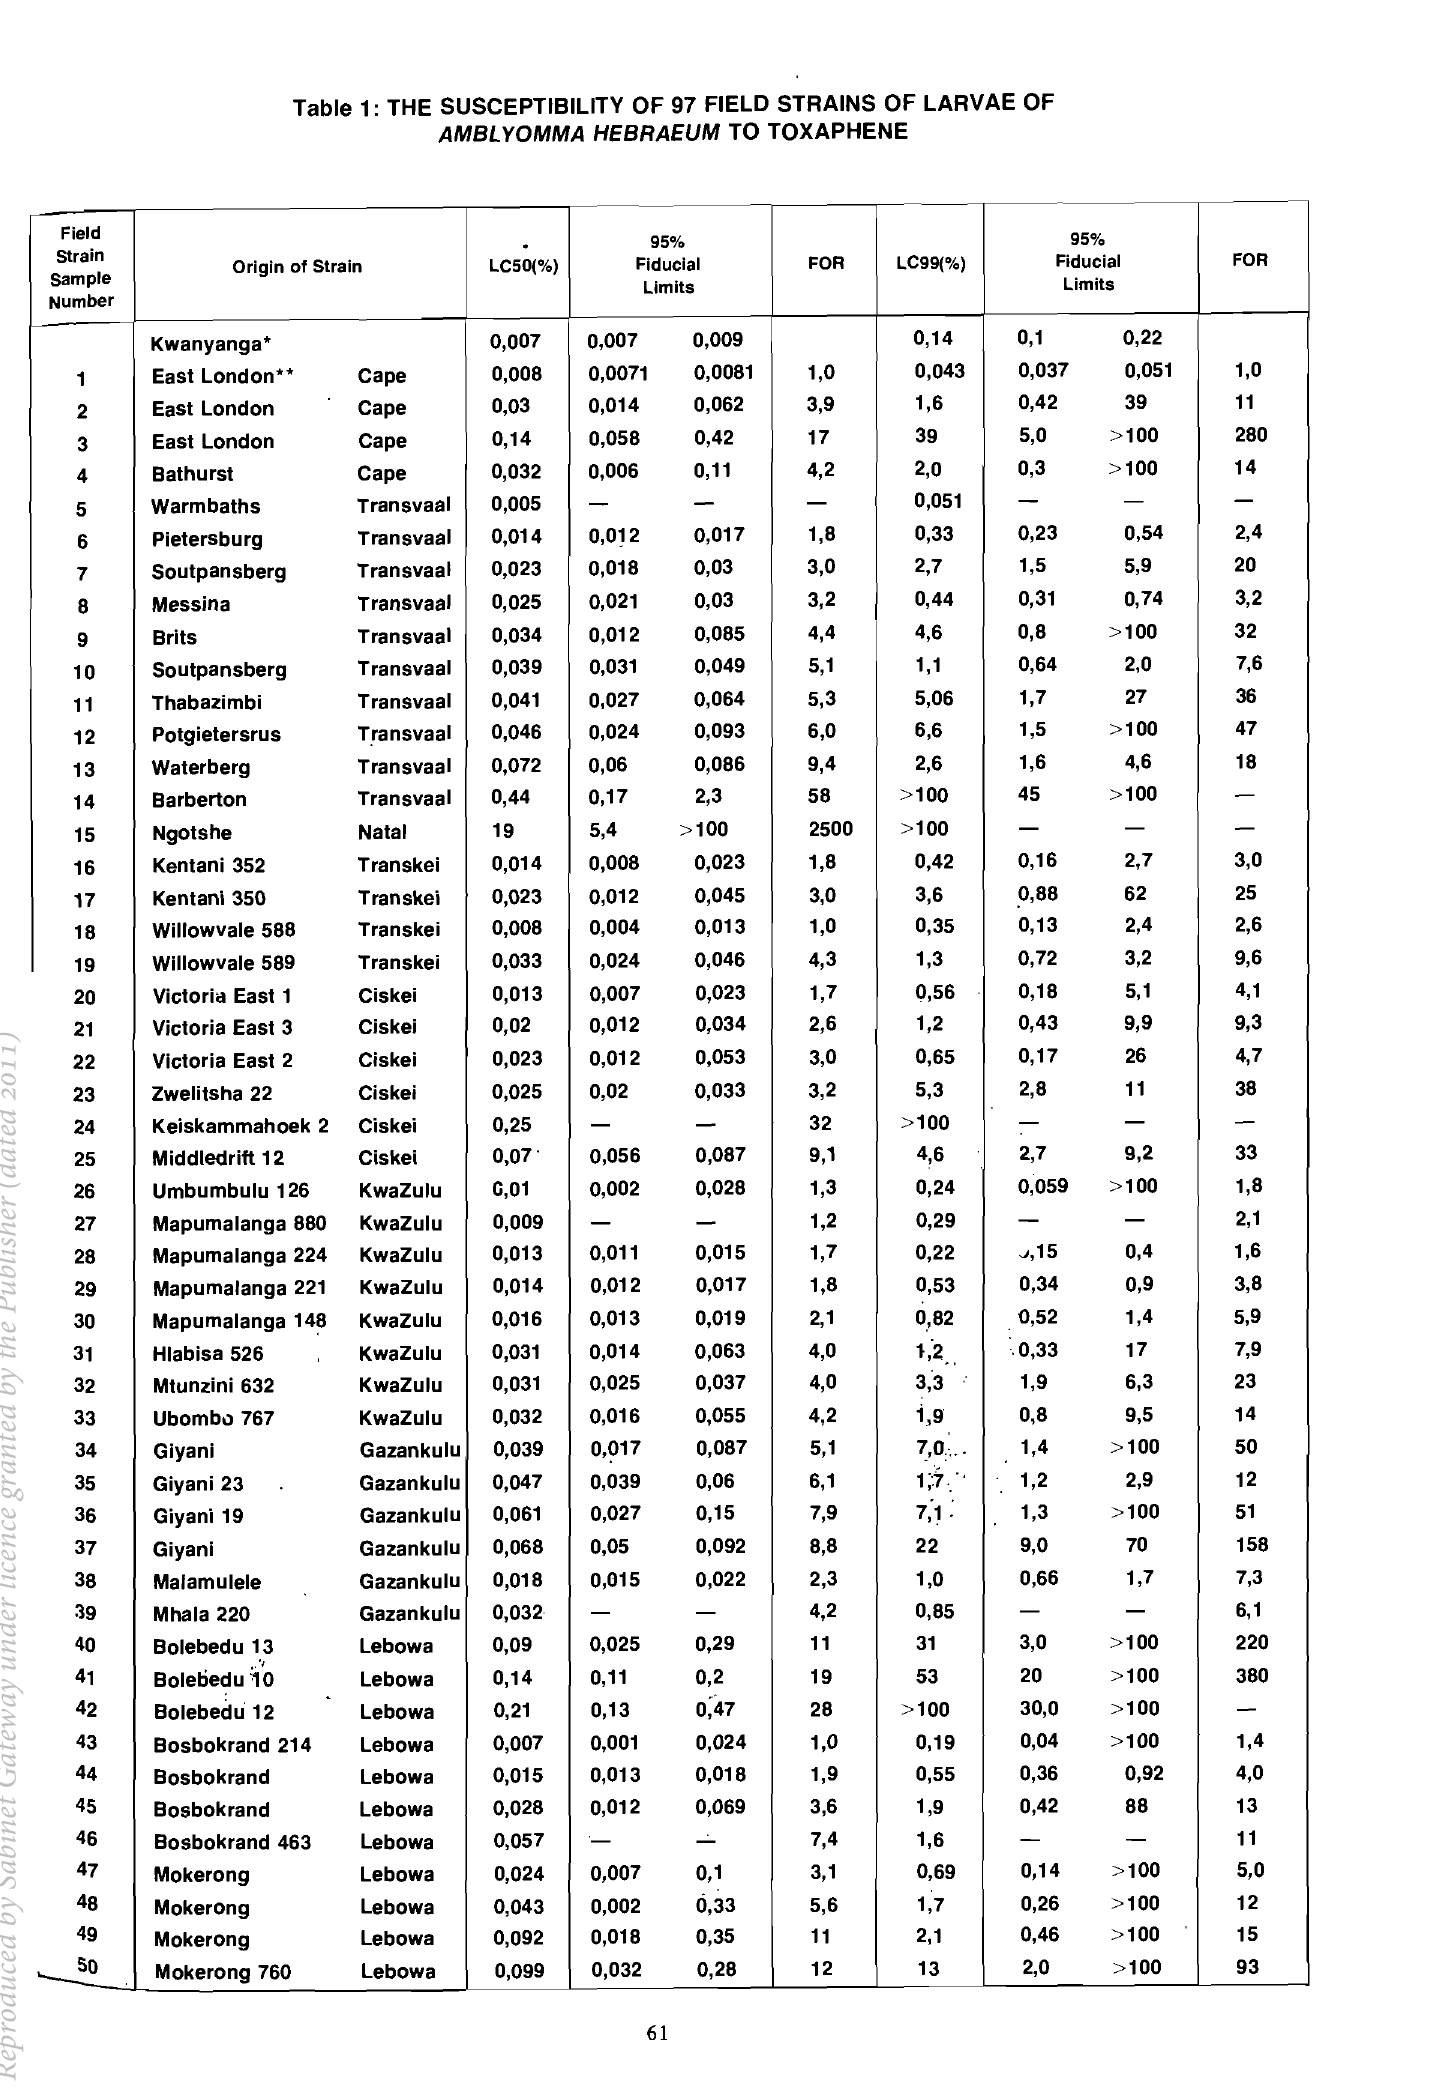
Table 1: THE SUSCEPTIBILITY OF 97 FIELD STRAINS OF LARVAE OF AMBL YOMMA HEBRAEUM TO